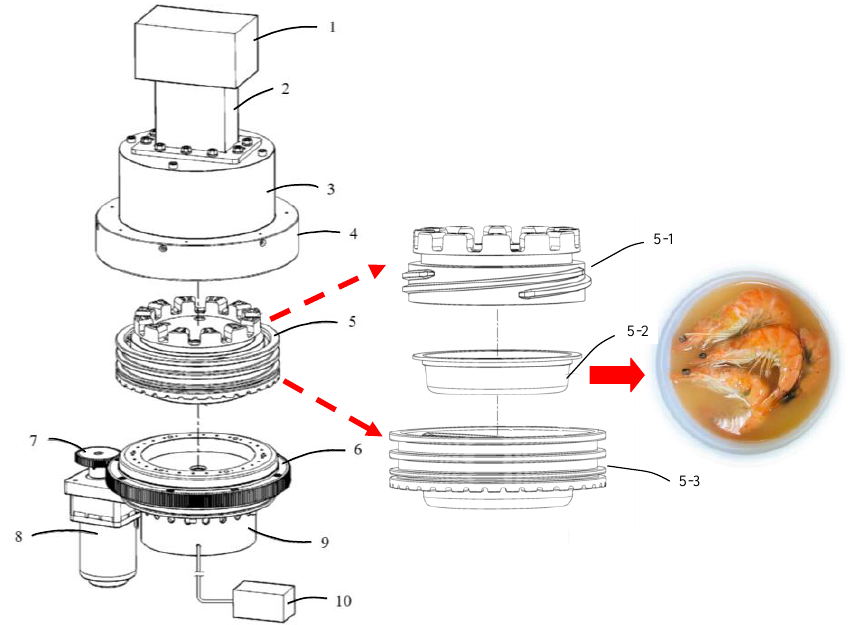
Figure 1. Microwave-assisted induction heating (MAIH) system diagram developed by Bottle Top Machinery Co., LTD., Taiwan. 1: Microwave heating unit; 2: Waveguide; 3: Microwave half-cavity body; 4: Microwave half-cavity cover; 5: Induction half-cavity; 6: Revolving take-over turntable; 7: Gears; 8: Rotating motor; 9: Induction heating unit; 10: Induction heating power controller; 5-1: Induction half-cavity upper cover; 5-2: Sealing crystallized polyethylene terephthalate (CPET) container; 5-3: Induction half-cavity body. Table 1. Heating conditions of MAIH system for white shrimp cooking.